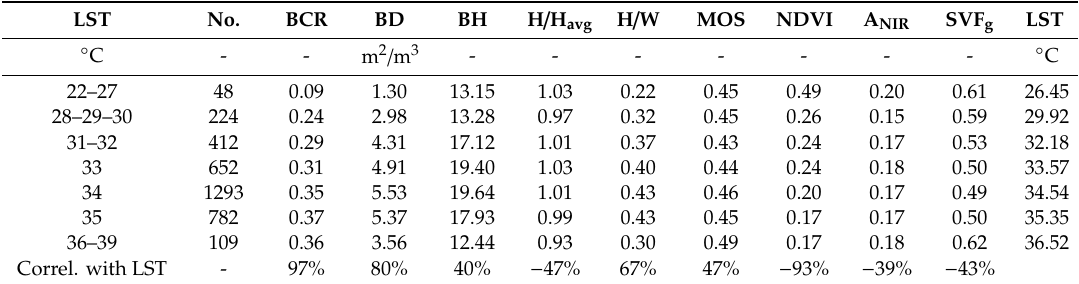
Table 11. Aggregated data according to LST values (first column).